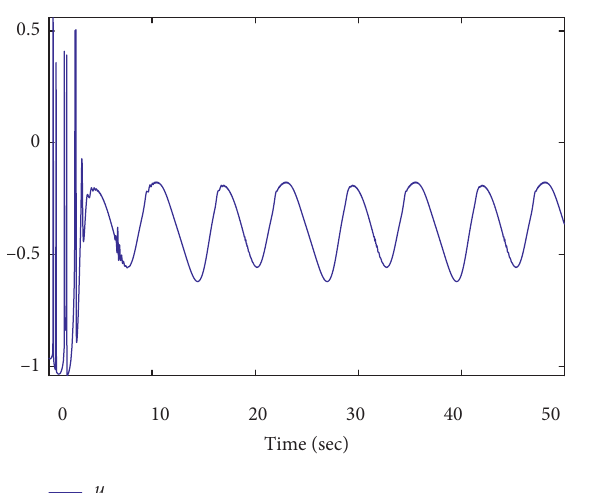
Figure 5: The input signal u .